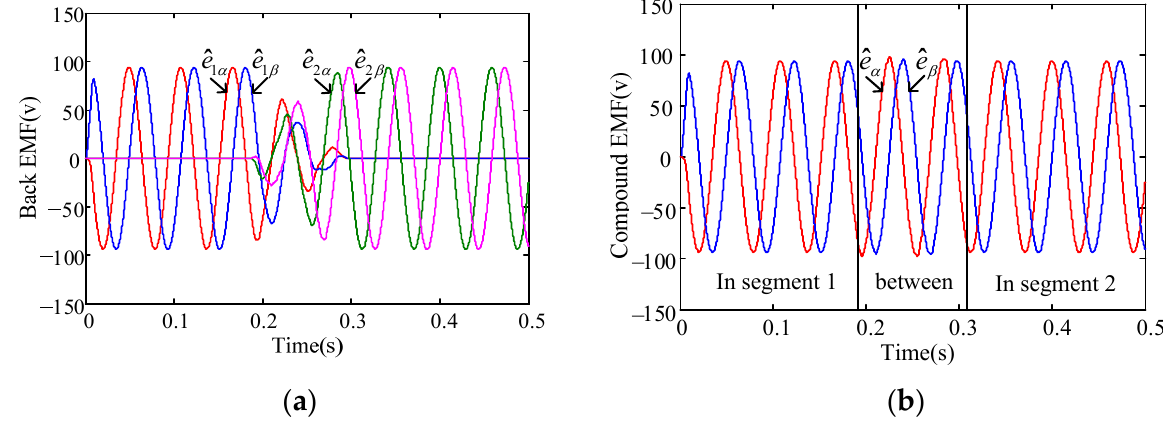
The parameters of the simulation are as follows: the feedback gain g1 is set to 37.8 and the poles p1, p2, and p3 are set to − 200, − 200, and − 800; the step signal of 1 m/s is given in the initial time; the accelerated ramp of 20 m/s 2 is given at the time of 0.1 s and the given speed of 3 m/s at the time of 0.2 s; the decelerated ramp of − 20 m/s 2 is given at 0.3 s, and the constant speed of 1 m/s is given at 0.4 s. Figures 7–9 show the simulation.